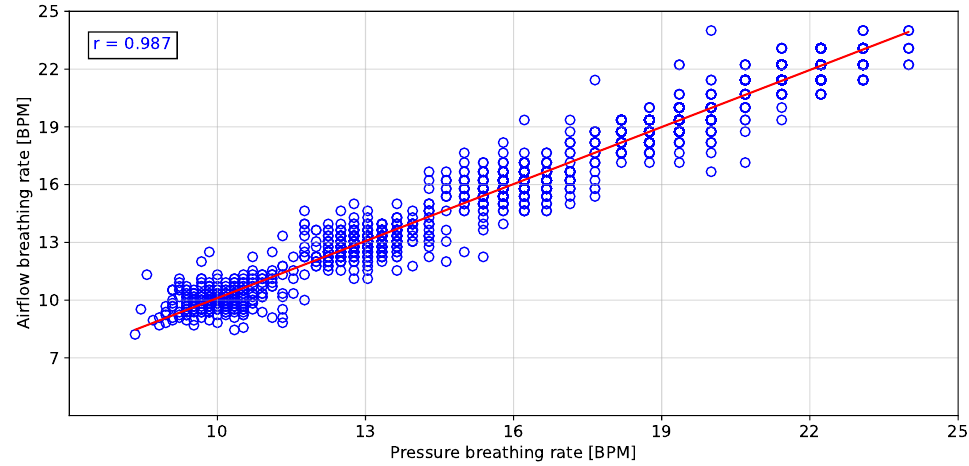
Figure 11. Pearson correlation of the breathing rate from the relative humidity signal respect to the airflow signal.